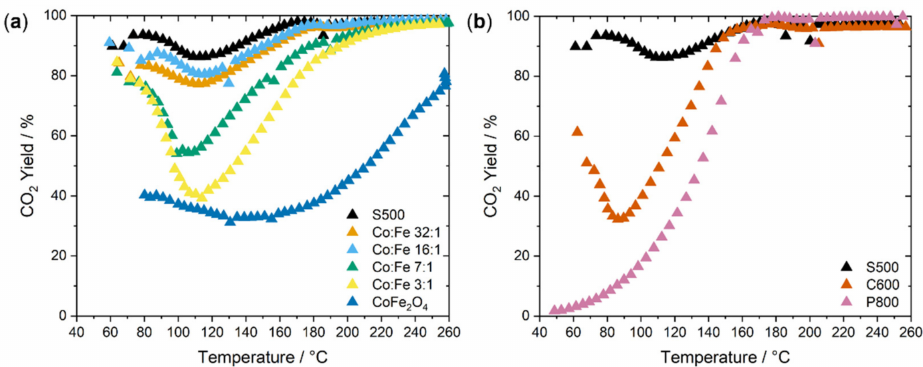
Figure 5. ( a ) Temperature-programmed CO oxidation activation of the SBA-15 templated Fe incor- poration series in the 3rd run. ( b ) Temperature-programmed CO oxidation activity of the different Co 3 O 4 samples in the 3rd